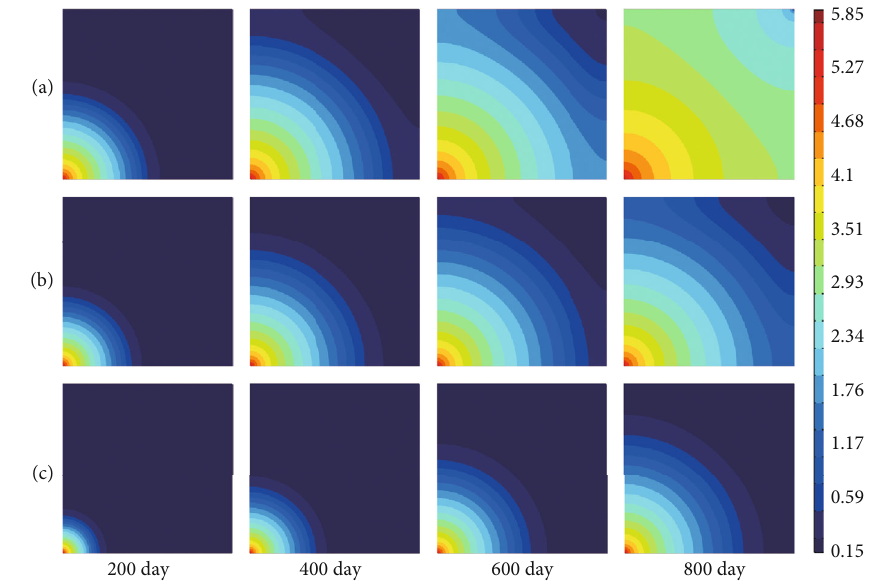
Figure 16: N migration within di ff erent sti ff ness of coal reservoir. (a) Lower sti ff ness. (b) Medium sti ff ness. (c) Higher sti ff 2